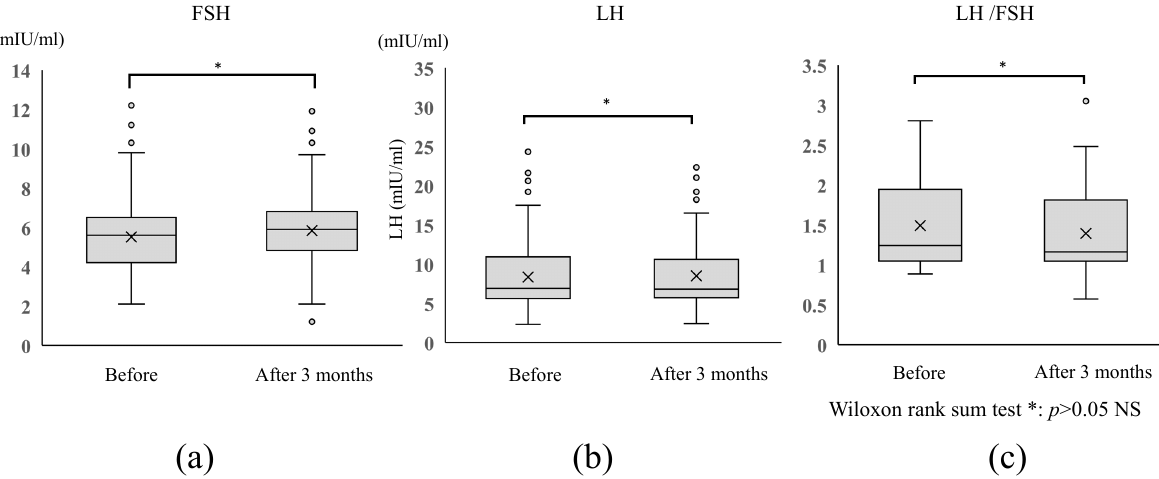
Figure 4. Changes in gonadotropins before and after administration of DNG 1 mg/day. No significant change in was observed between before and at 3 months after administration of DNG 1 mg/day in terms of ( a ) serum FSH level, ( b ) serum LH level, or ( c ) LH/FSH ratio (all p <